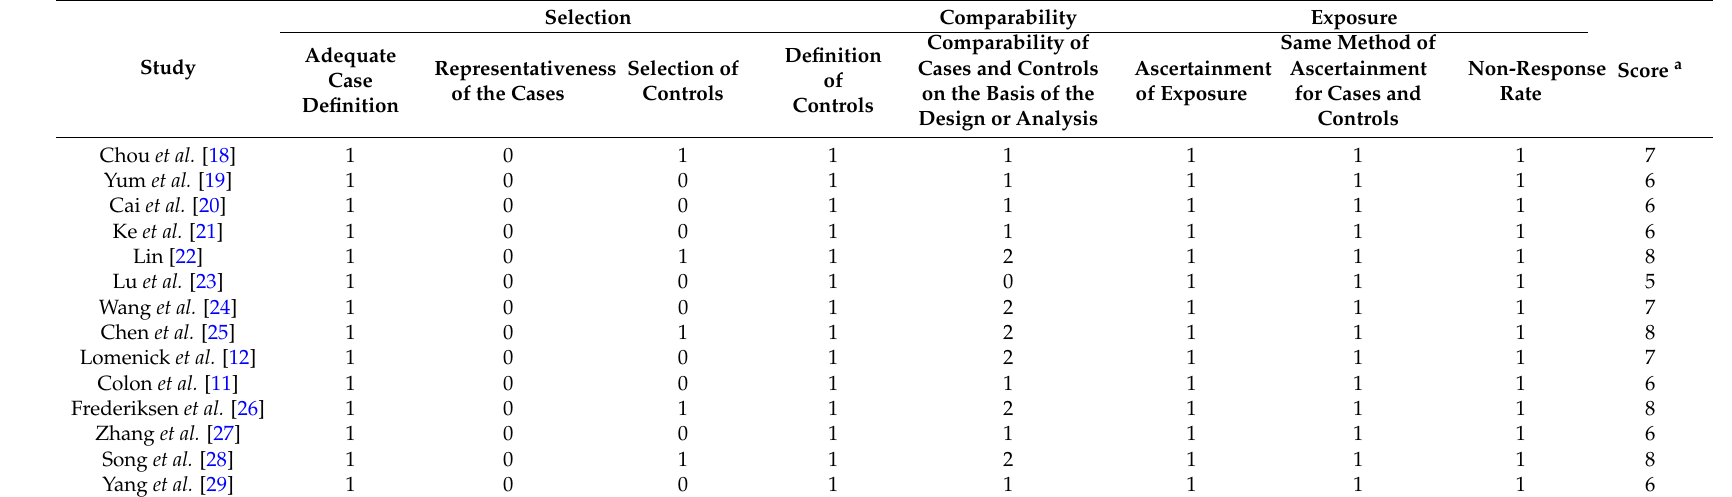
Table 2. The Newcastle-Ottawa Scale (NOS) for assessing the methodology